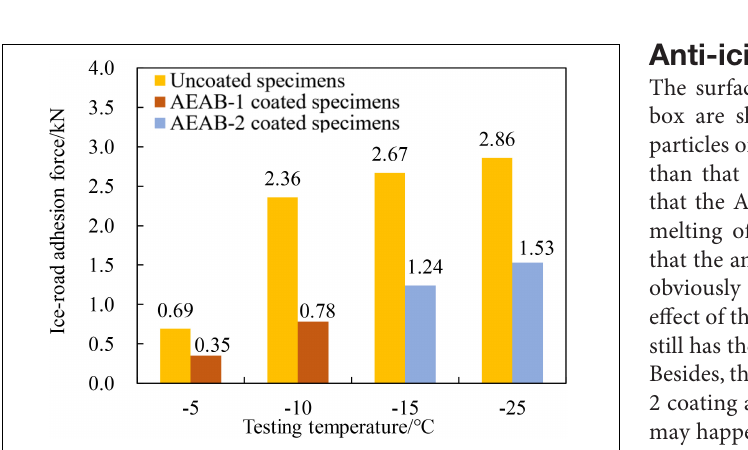
demulsification more than 20 h. So, there is enough time for the production and construction of AEAB.